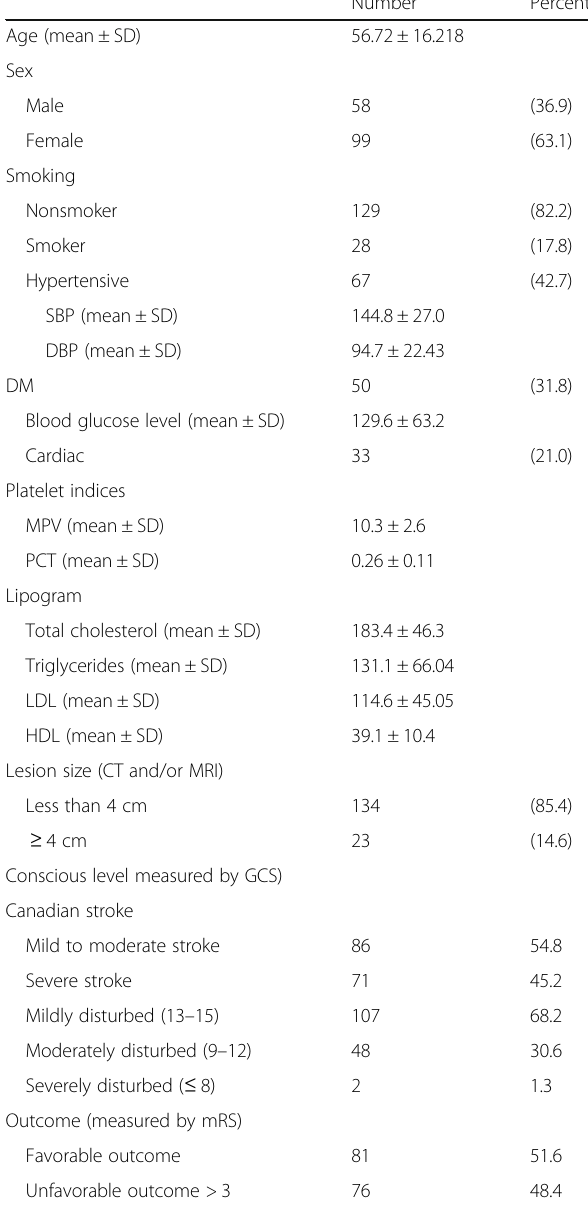
Table 1 Baseline characteristics of